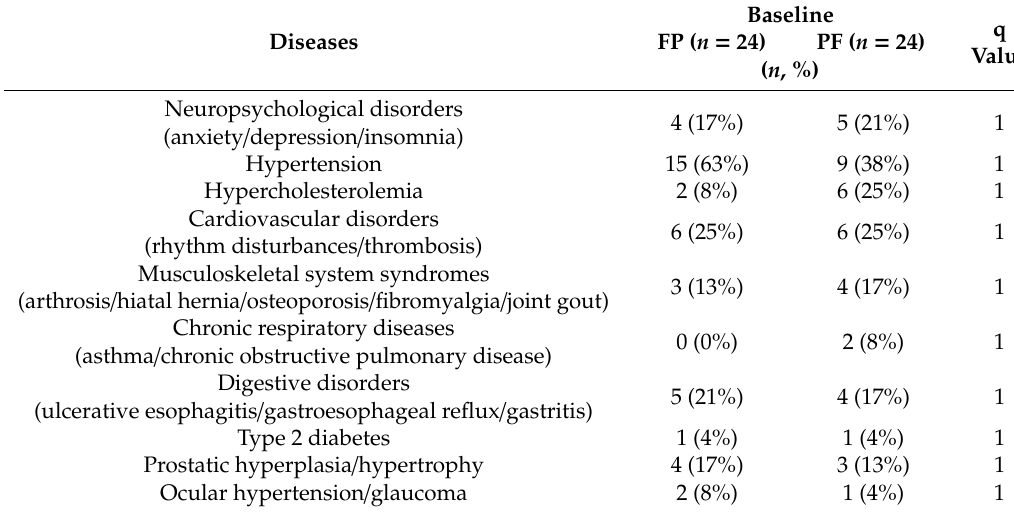
Table 1. Baseline diseases / medications of the study